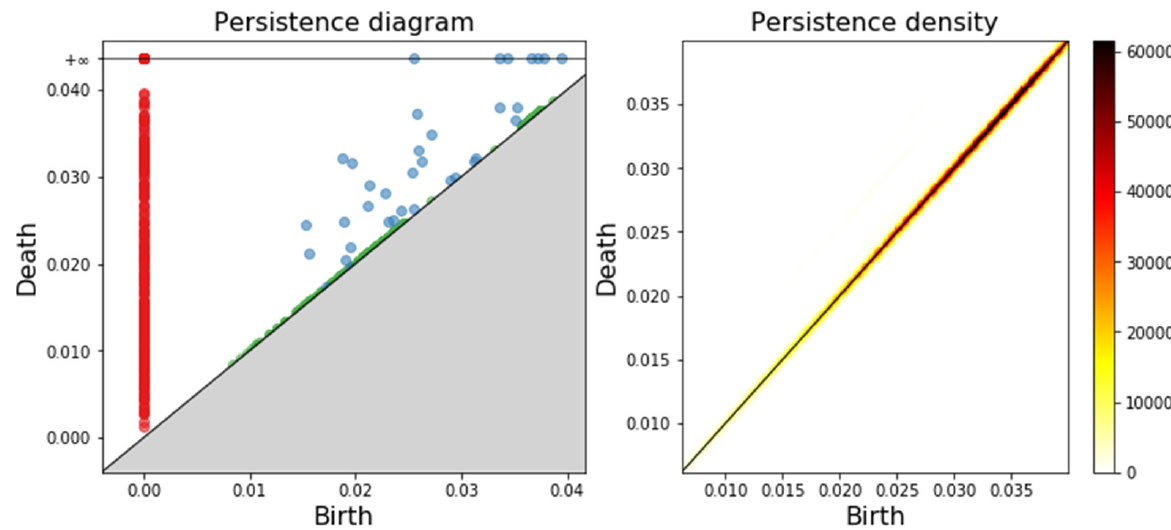
Figure 7. Data persistence diagram ( left ) and persistence density diagram ( right ).